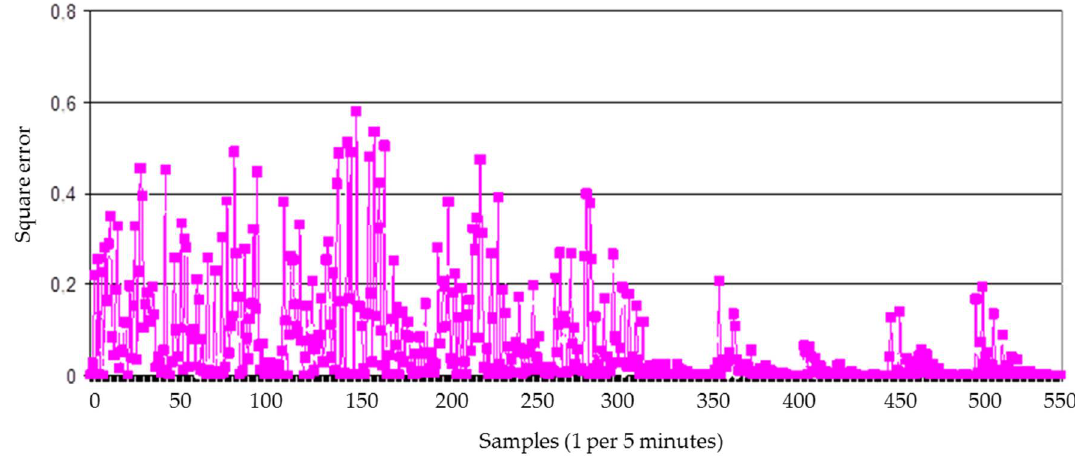
Figure 6. UVI Square error for each sample.